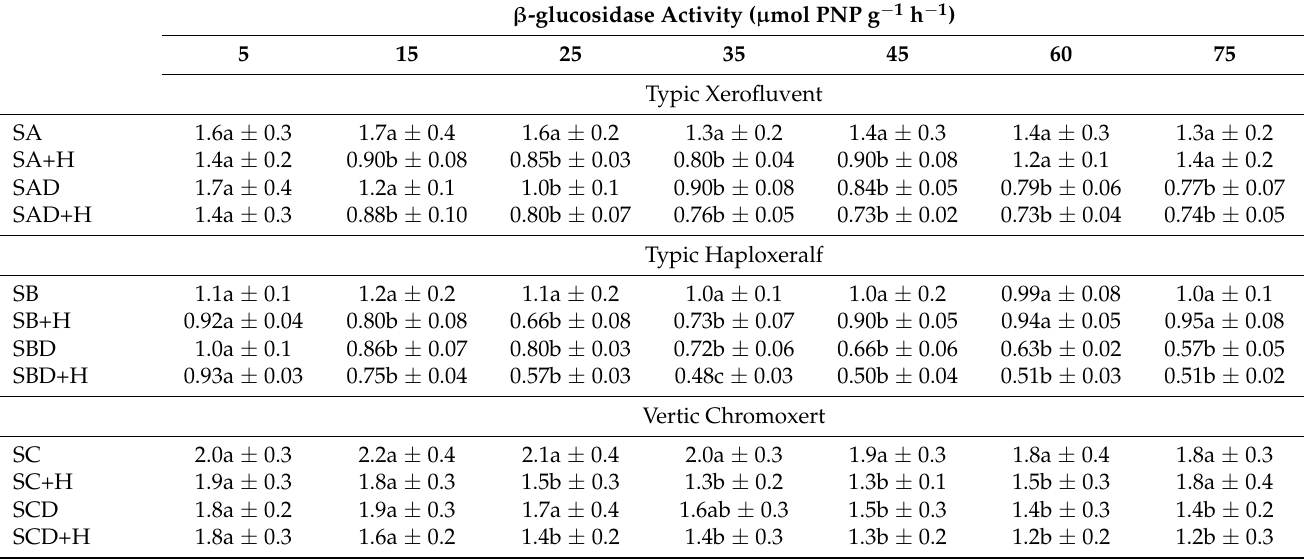
Table 4. Evolution of β -glucosidase activity (mean ± standard error, n = 3) in watered and non- watered soils with MCPA during the experiment.